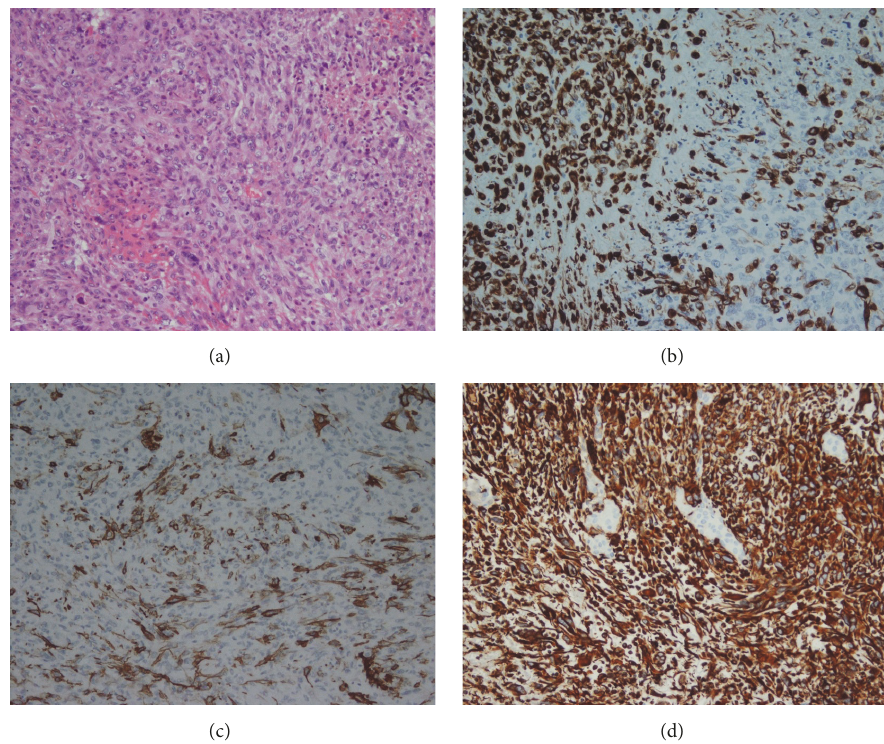
Figure 3: Histopathology of the tumor. (a) Hematoxylin-eosin stain. The epithelial part of the tumor consists of high-grade urothelial carcinoma and the mesenchymal part is composed of oval to spindle shaped cells proliferation. (b) Immunohistochemical staining indicatesCK-7positive.(c)Immunohistochemicalstainingshows 𝛼 -smoothmuscleactinpositive.(d)Immunohistochemicalstainingreveals vimentin